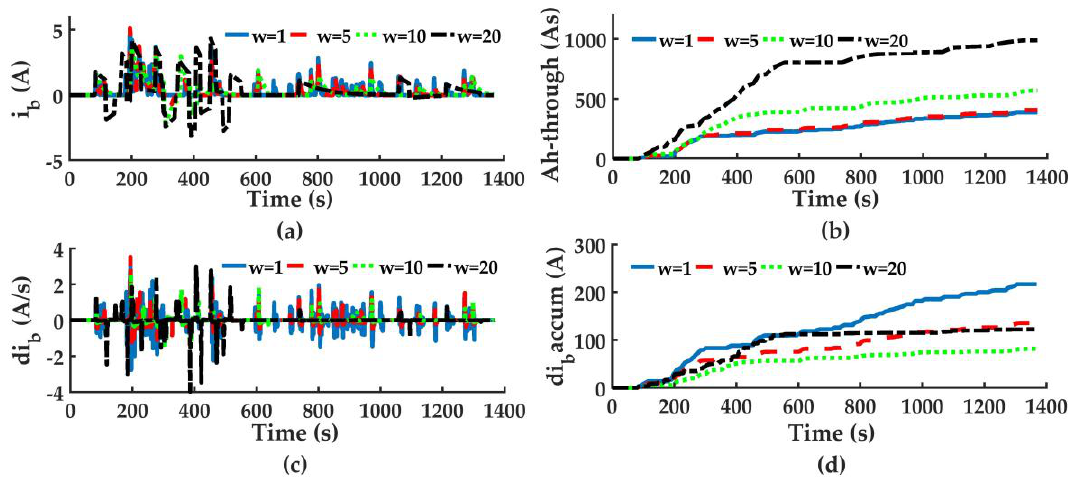
Figure 13. Simulation results with different w 7. ( a ) LiB current; ( b ) LiB Ah-throughput; ( c ) LiB current rate; ( d ) Accumulated LiB current rate.